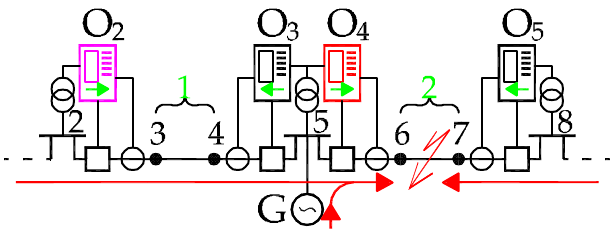
Figure 2. Part of distributed generation system (DGS).